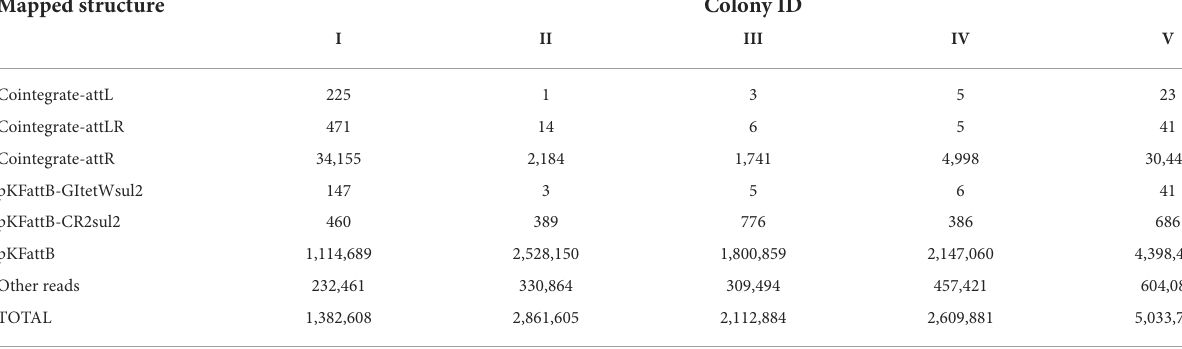
TABLE 1 Number of nanopore reads unambiguously mapping on each possible recombinant structure described in Figure 3C, in five of the 12 randomly selected recombinant colonies. Mapped structure Colony ID